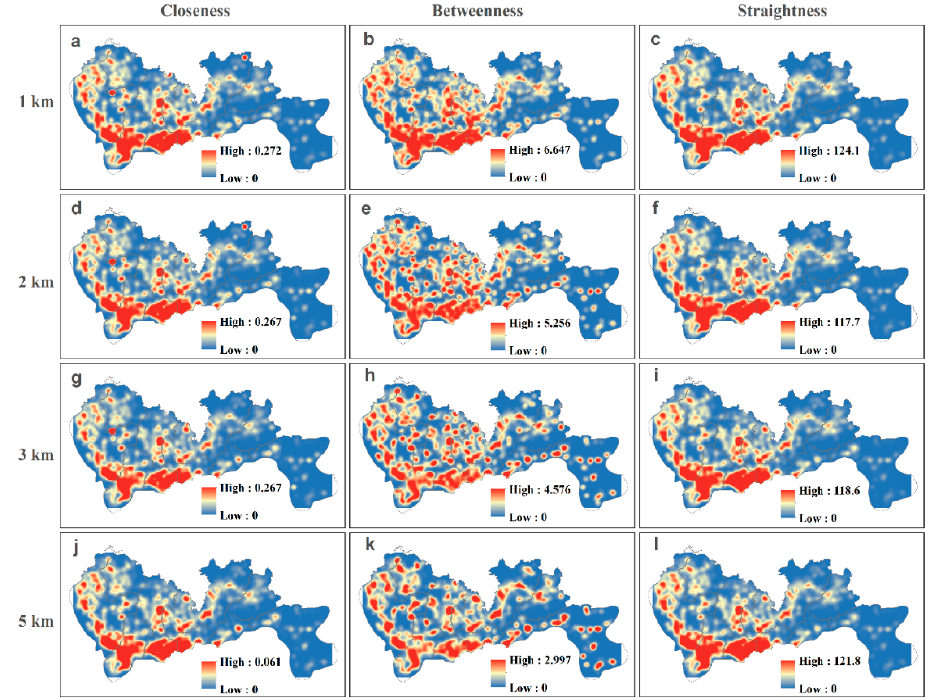
Figure 10. Spatial patterns of KDE of the local street centralities using searching radiuses of 1 km, 2 km, 3 km, and 5 km. The same vertical column shares the same centrality indicator: Closeness, Betweenness, and Straightness, from left to right, respectively. The same horizontal row shares the same searching radius: 1 km, 2 km, 3 km, and 5 km, from top to bottom, respectively. Table 2. Pearson’s r between local street centralities and land use intensities in the 1 km grid.